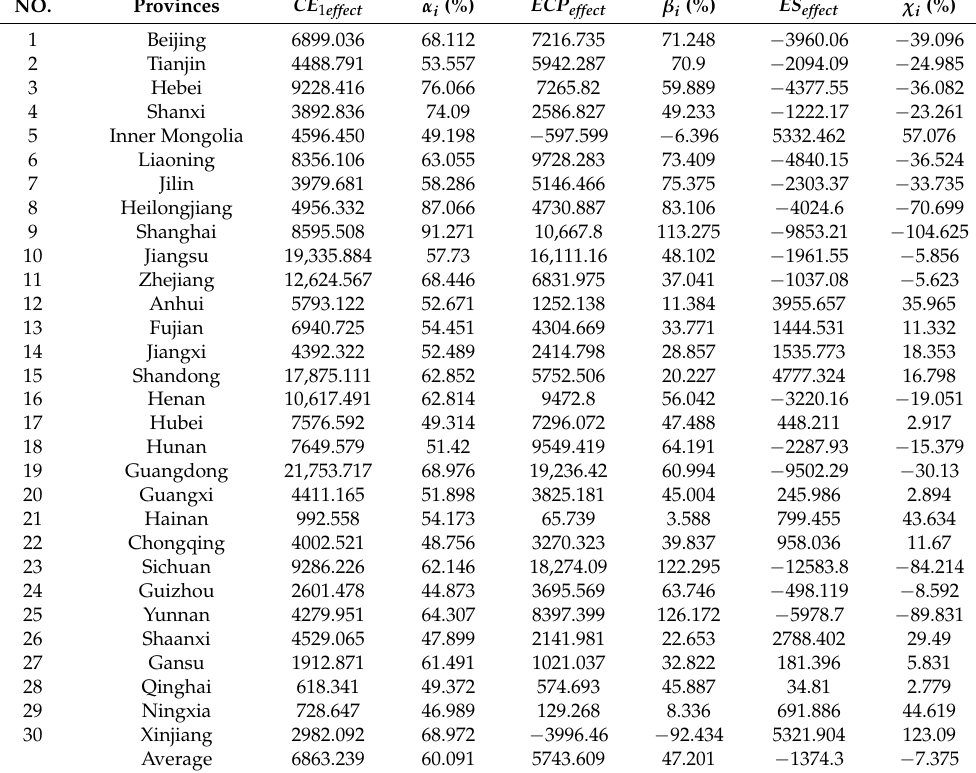
Table A3. First-stage decomposition results for each